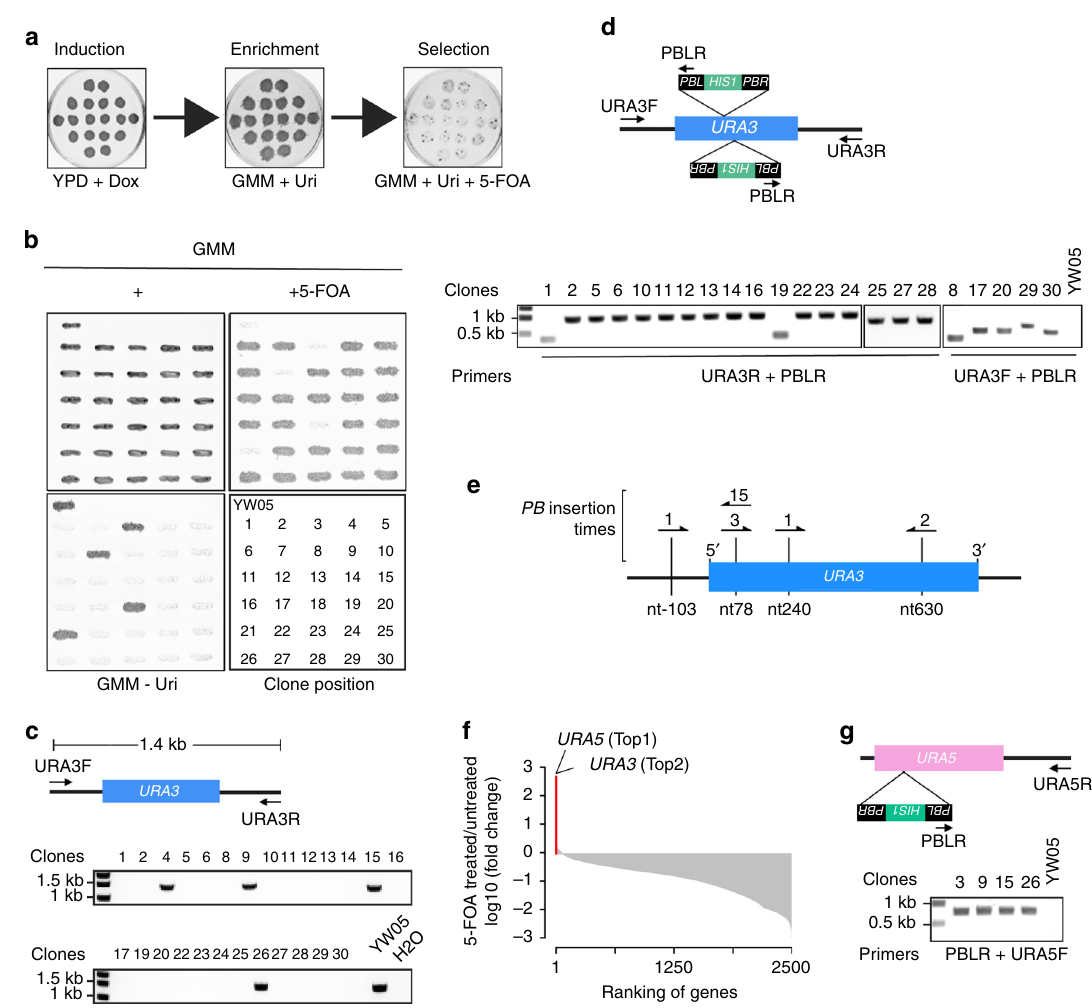
Fig. 3 Genetic screen for 5-FOA-resistant mutants caused by PB transposition. a An illustration of the screening procedure. b Con fi rmation of the phenotype of 5-FOA-resistant mutants. Strains grown on a GMM + Uri + Arg + His ( + ) plate were replica-transferred onto a GMM + Uri + 5-FOA ( + 5-FOA) or GMM + Arg + His (GMM – Uri) plate and then incubated at 30 °C overnight. YW05 was included as a control. The lower right panel shows the strain layout. c Characterization of 5-FOA-resistant mutants by colony PCR. Arrows indicate the primers used to detect URA3 . d PCR identi fi cation of PB insertion sites at the URA3 locus of the true 5-FOA-resistant clones from b . Arrows indicate the primers used. e PB insertion sites identi fi ed at the URA3 locus. Sequence analysis identi fi ed four different sites indicated by vertical lines. Arrows denote PB insertions, and the direction of arrows indicate the direction of HIS1 transcription in PB . The numbers indicate the number of mutants associated with each insertion site. f Fold changes of genes with PB inserts after growing the mutant library in media containing 5-FOA in comparison with the same library grown in normal media. The top two genes are highlighted in red. g PCR identi fi cation of PB insertion sites at the URA5 locus. Arrows denote the primers